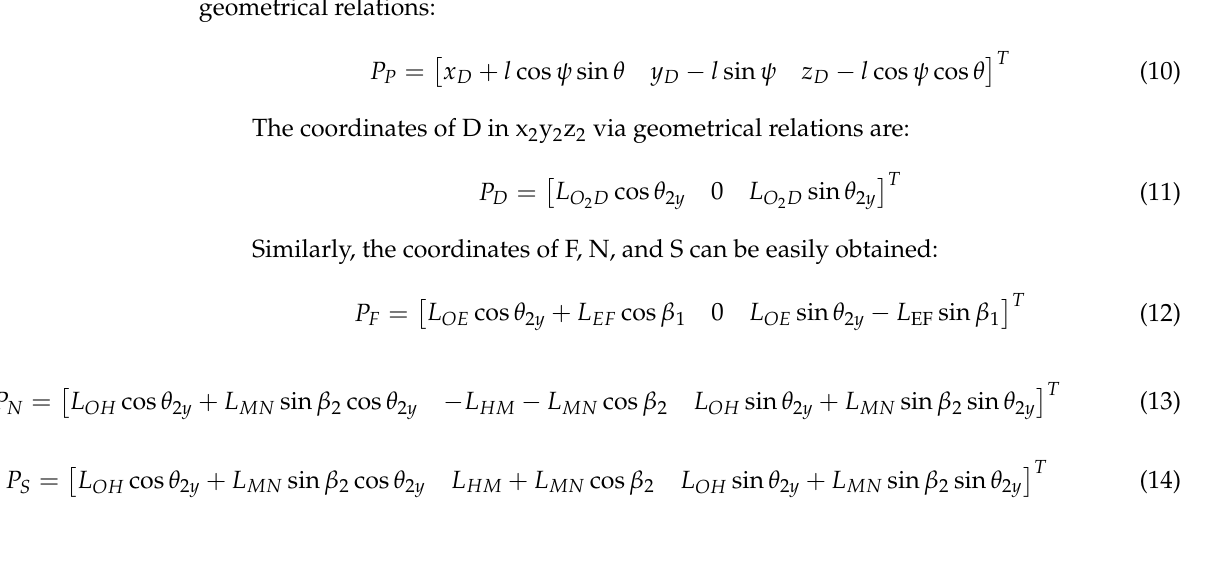
Figure 4. Top view of mechanical structure: ( a ) top view of three-dimensional mechanical structure; ( b ) simplified top view of two-dimensional mechanical structure.